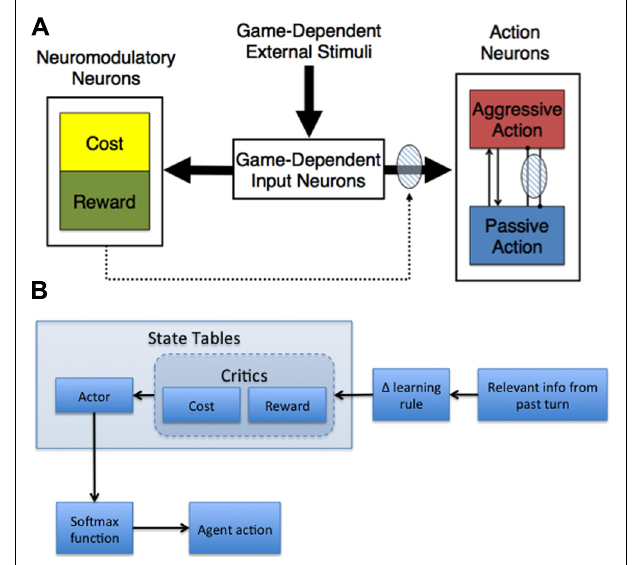
FIGURE 2 |Adaptive agent architectures. (A) General neural network architecture for Hawk-Dove and Chicken studies.The thick arrows represent all-to-all connections.The dotted arrows with the shaded oval represent modulatory plastic connections.Within the Action Neurons region, neurons with excitatory reciprocal connections are represented as arrow-ended lines, and neurons with reciprocal inhibitory connections are represented as dot-ended lines overlaid by a shaded oval, which denotes plasticity. (B) Actor-Critic schematic.The behavior of the adaptive agent used in the Stag Hunt experiment (Craig etal., 2013) was controlled by an Actor-Critic model. The model was comprised of three state tables – Actor, Cost Critic, and Reward Critic – which were updated with relevant information from the most recent turn in the current game and then used to determine whether the agent should hunt stag or hare on the next turn.The payoff information from the last turn was combined with the cost/reward value associated with the current state (determined by the locations of tokens on the board) from each respective critic using a delta-learning rule.These modified values were then used to update the corresponding state in the Actor table, which was used in a SoftMax function to generate probabilities for hunting stag and hare.Those probabilities were then used to determine the agent’s action on the upcoming